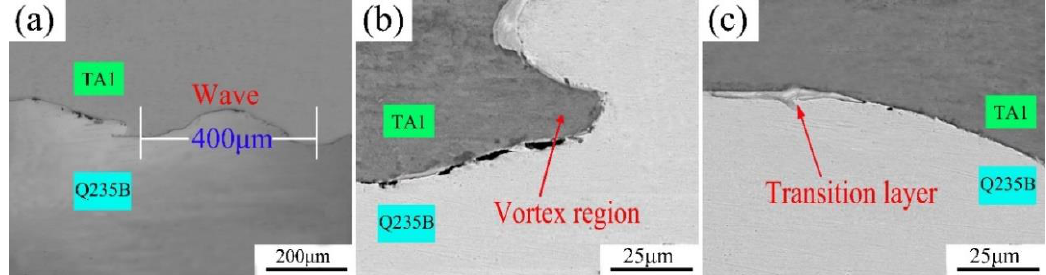
Figure 3. ( a ) SEM of the TA1/Q235B interface: ( b ) the vortex region and ( c ) transition layer.